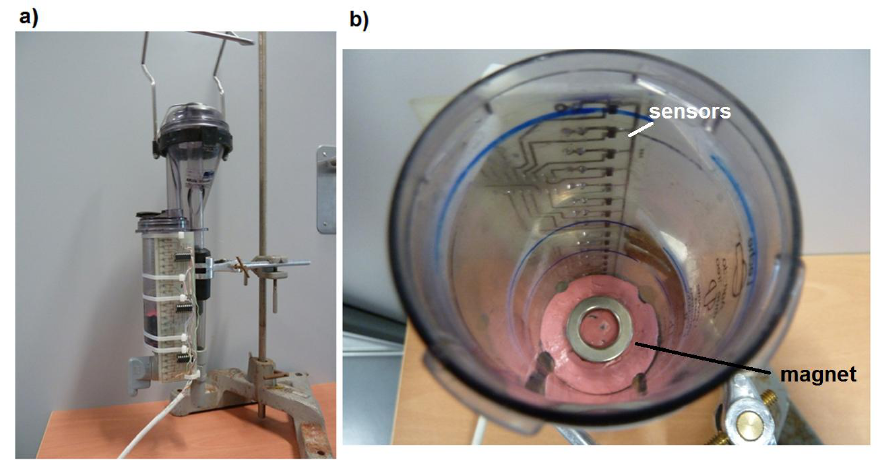
Figure 1. Photographs of the electronic system and its location in the proportional meter, ( a ) front view of the proportional meter whit the electronic circuit attached, ( b ) view from above of dismounted receiving container, showing part of the array of Hall Effect sensors and the magnet over the pink